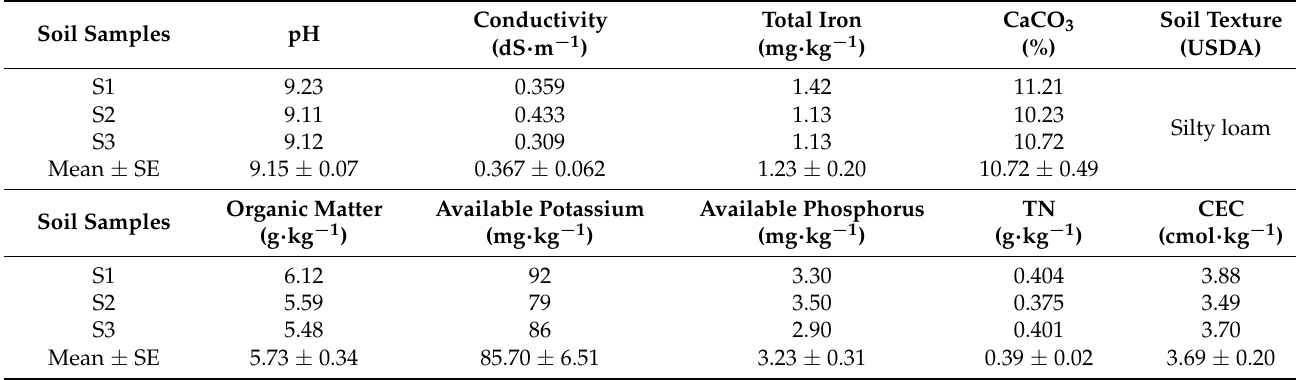
Table 1. Physical and chemical characteristics of test soil.